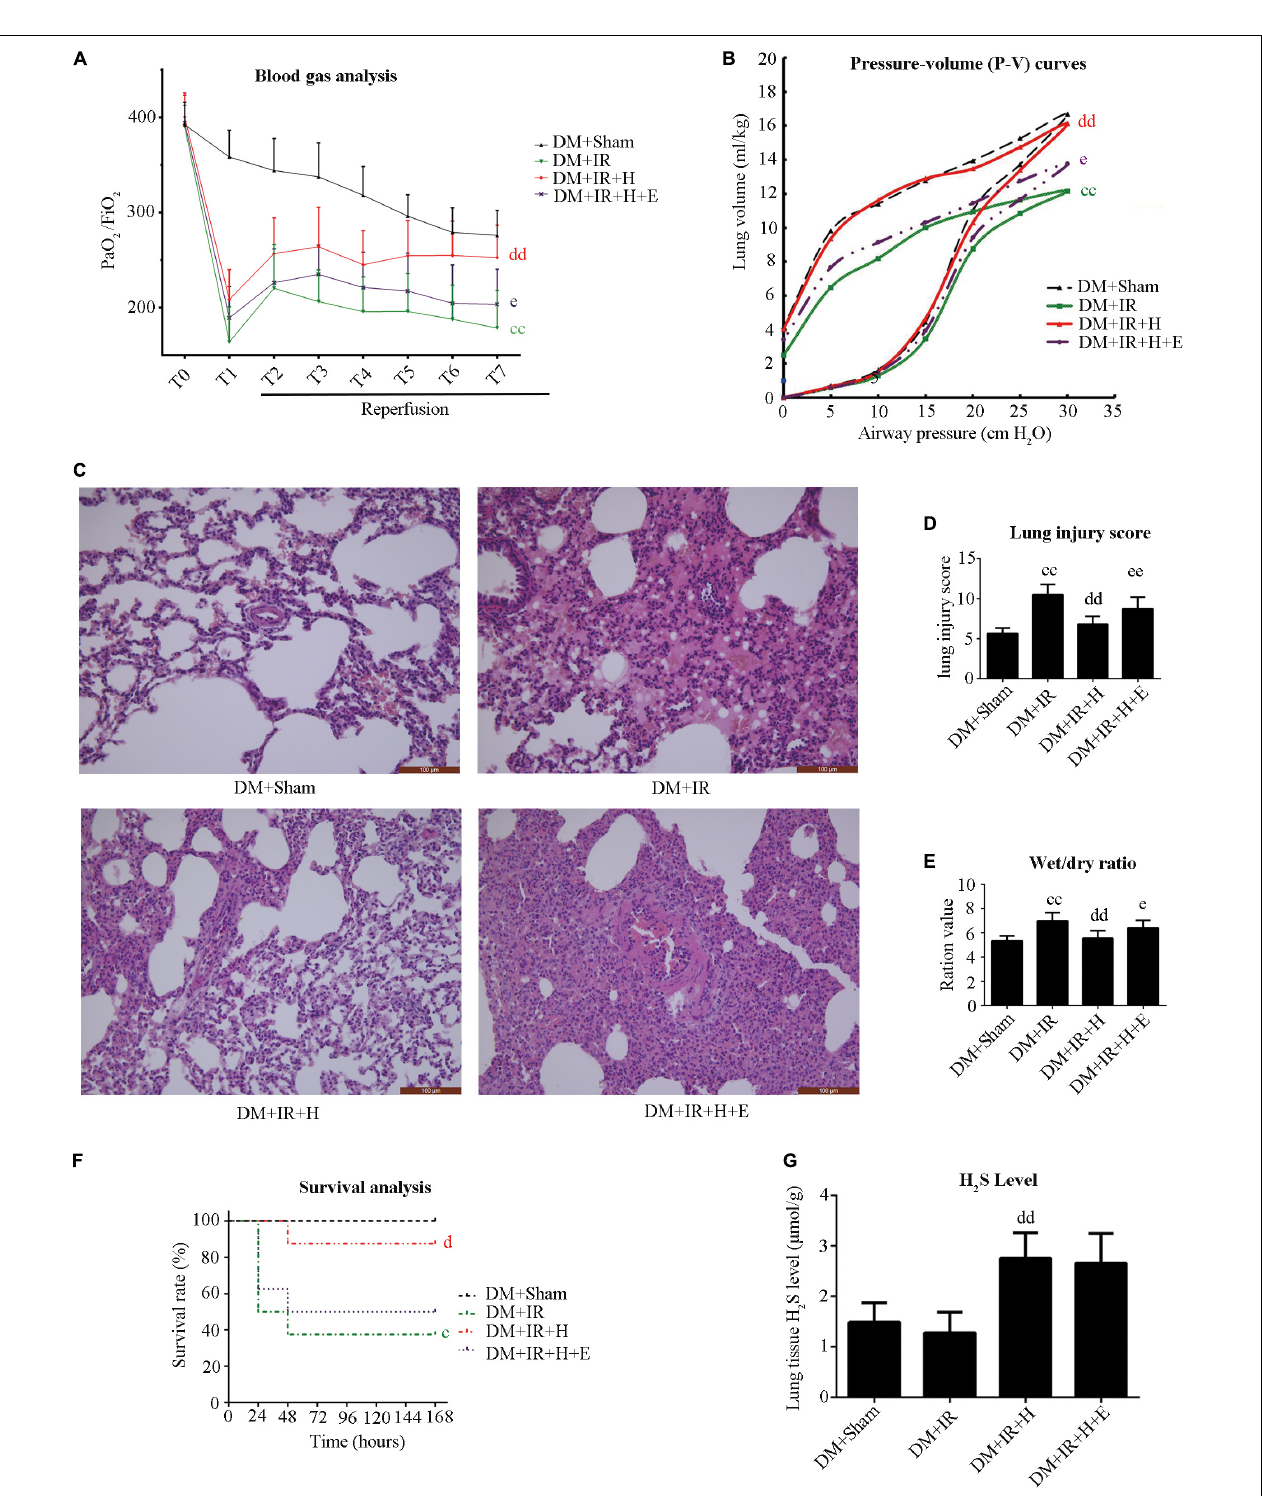
FIGURE 3 | EX527 blunted GYY4137-induced pulmonary protective effect on lung IR injury in type 2 diabetic rats. (A) Arterial blood gas analysis. T0–T7 represent the following time points: baseline, end of ischemia, and 30, 60, 90, 120, 180, and 240 min after reperfusion. (B) Static compliance of the lung pressure–volume (P–V) curves. Data are represented by the mean values, and the bars are omitted for clarity. (C) Histologic analysis of lung tissues. (magnification: 200 × ). (D) Lung injury score. (E) Wet/dry weight ratio. (F) Survival analysis. Rats were observed for 168 h (1 week), and survival time was calculated. (G) Lung H 2 S levels in rat ( c P < 0.05 versus DM + sham group/ cc P < 0.01 versus DM + sham group, d P < 0.05 versus DM + IR group/ dd P < 0.01 versus DM + IR group, e P < 0.05 versus DM + IR + H group/ ee P < 0.01 versus DM + IR + H group; n = 8 in each group).